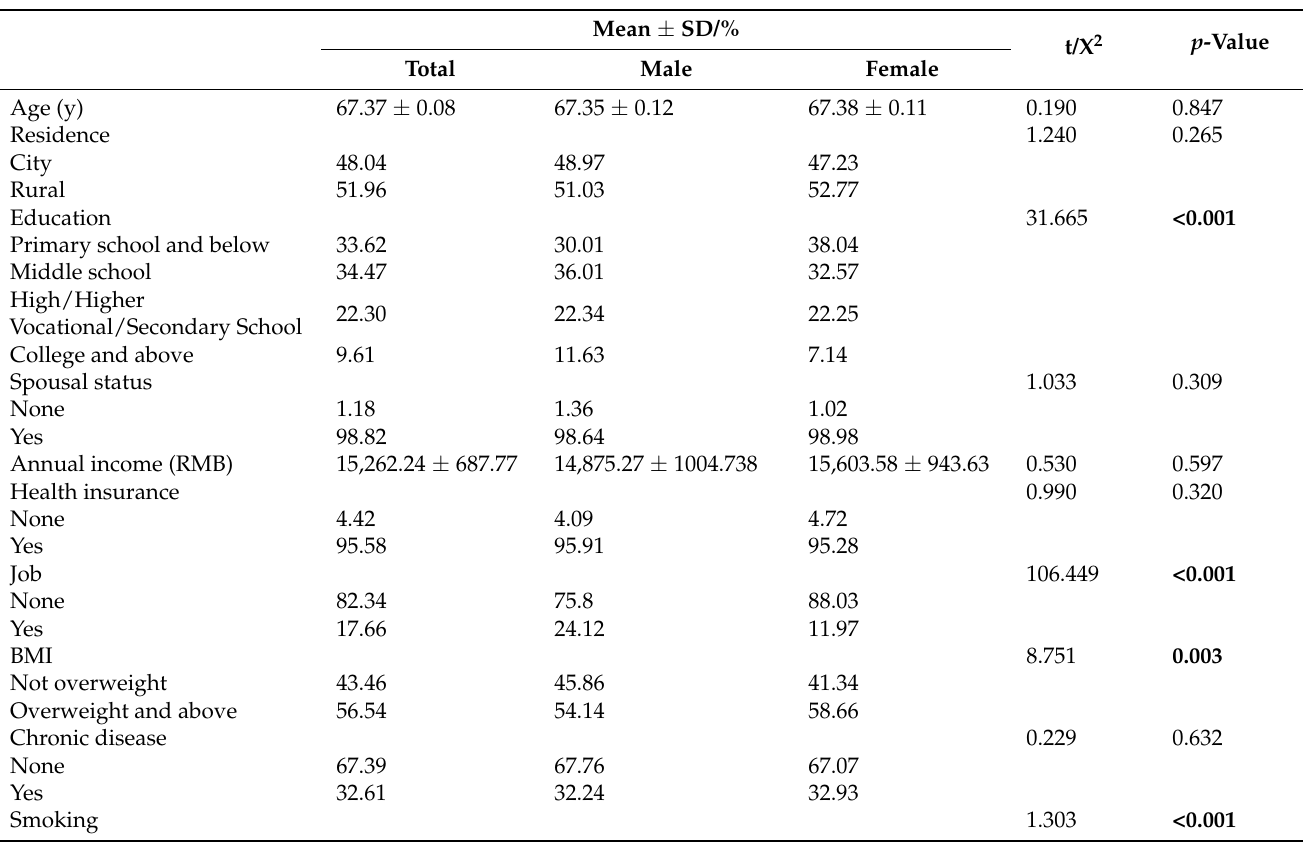
Table 1. Characteristics of older people in